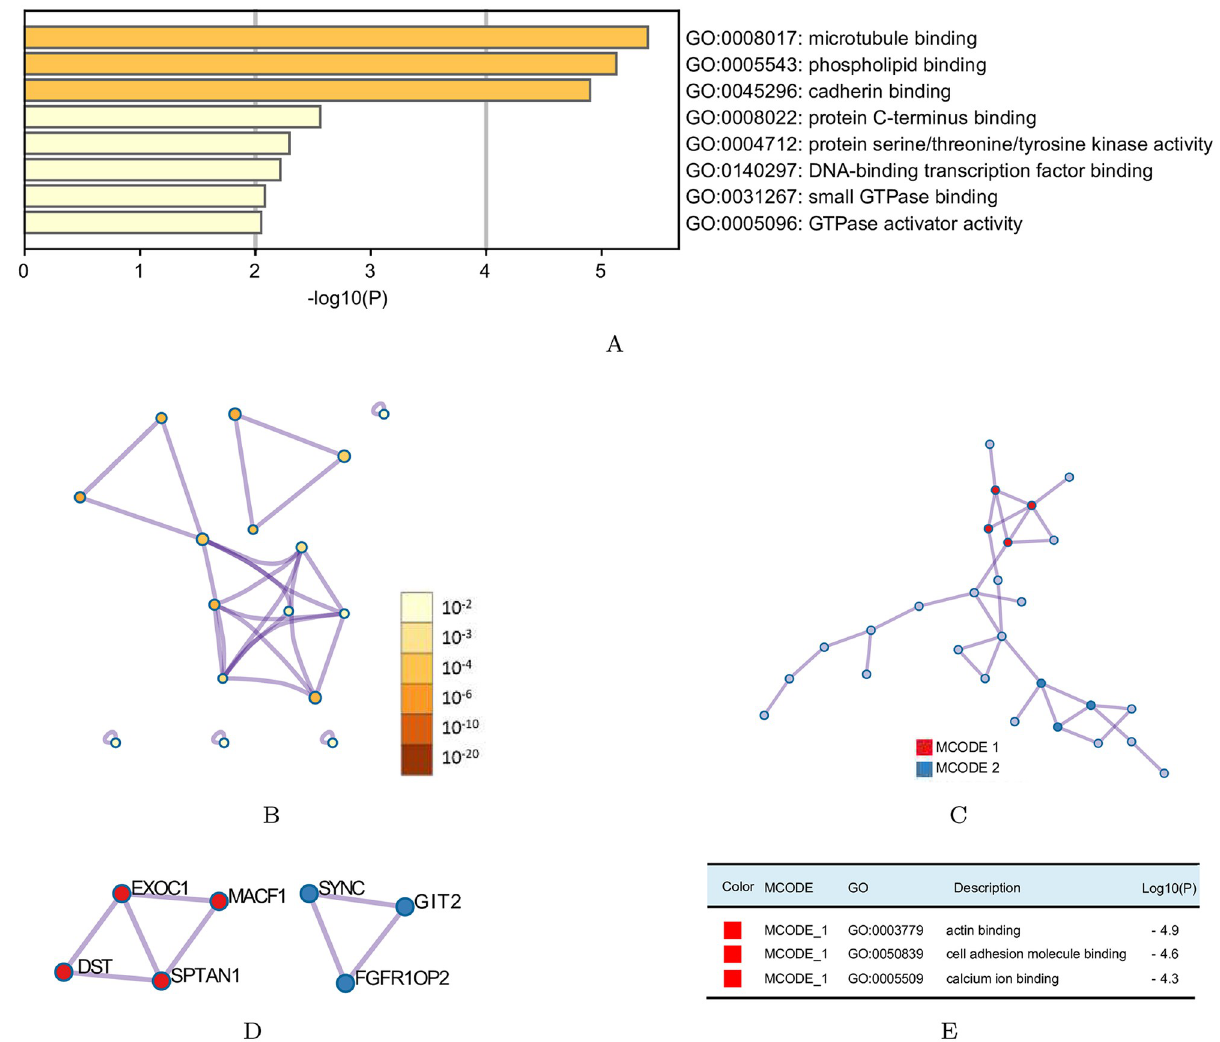
Fig 5. Enrichment analysis of the marker genes identified by PCB (Metascape). (A) Pathway and process enrichment analysis has been carried out with Gene Ontology (GO) Molecular Functions. Bar graph of enriched terms across the marker genes, colored by p -values. (B) Network of enriched terms across the marker genes: colored by p -value, where terms containing more genes tend to have a more significant p -value. (C) Protein-protein interaction network and the MCODE component identified in the marker genes. (D) Pathway and process enrichment analysis has been applied to the MCODE component. The three best-scoring terms by p -value have been retained as the functional description of the MCODE components, shown in Table (E).